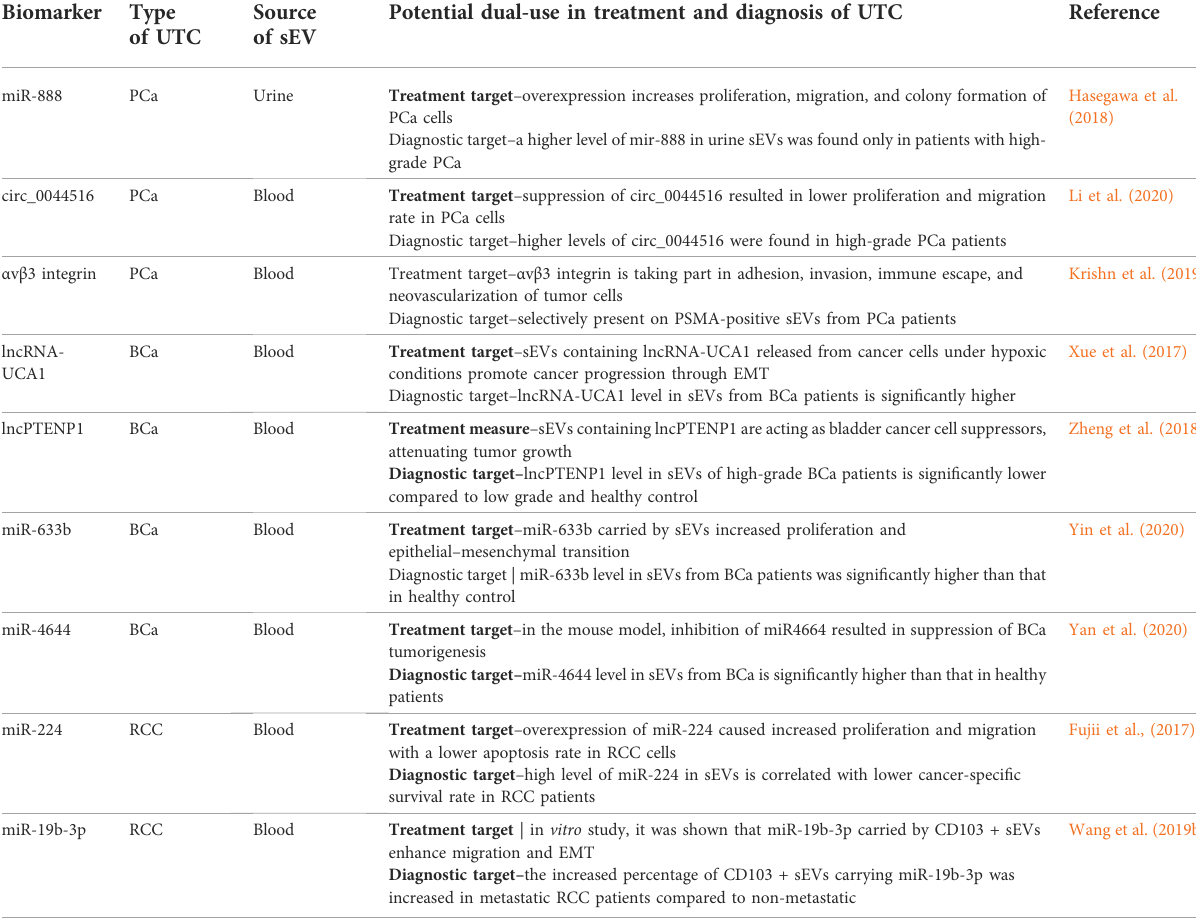
TABLE4ExamplesofbiomarkerswithbothdiagnosticandtherapeuticpotentialinUTC.BCa – urinarybladdercancer,UTC – urinarytractcarcinomas, PCa – prostate cancer, RCC – renal cell carcinoma, EMT – epithelial – mesenchymal transition, sEVs – small extracellular